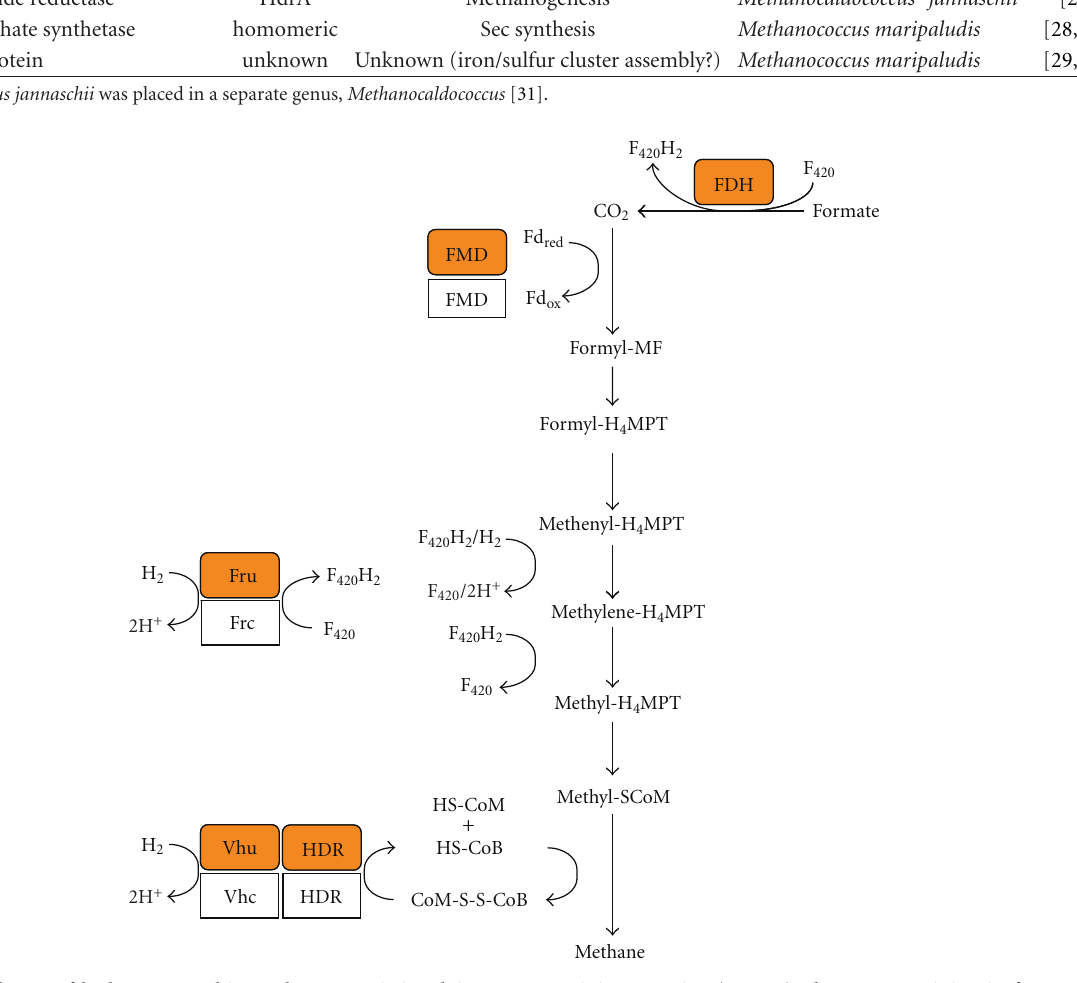
Figure 1: Scheme of hydrogenotrophic methanogenesis involving Sec-containing proteins (orange); the Cys-containing isoforms are in white. CoM-S-S-CoB, heterodisulfide of coenzyme M and coenzyme B; Fd, ferredoxin; Fd ox , oxidized Fd; Fd red , reduced Fd; FDH, formate dehydrogenase; FMD, formyl-methanofuran dehydrogenase; Fru, F 420 -reducing hydrogenase; F 420 , (oxidized) 8-hydroxy-5-deazariboflavin derivative; F 420 H 2 , reduced coenzyme F 420 ; H 4 MPT, tetrahydromethanopterin, HDR, heterodisulfide reductase; HS-CoB, coenzyme B ( N- 7- mercaptoheptanoyl- O -phospho- L -threonine); HS-CoM, coenzyme M (2-mercaptoethanesulfonic acid); MF, methanofuran; Vhu, F 420 - nonreducing